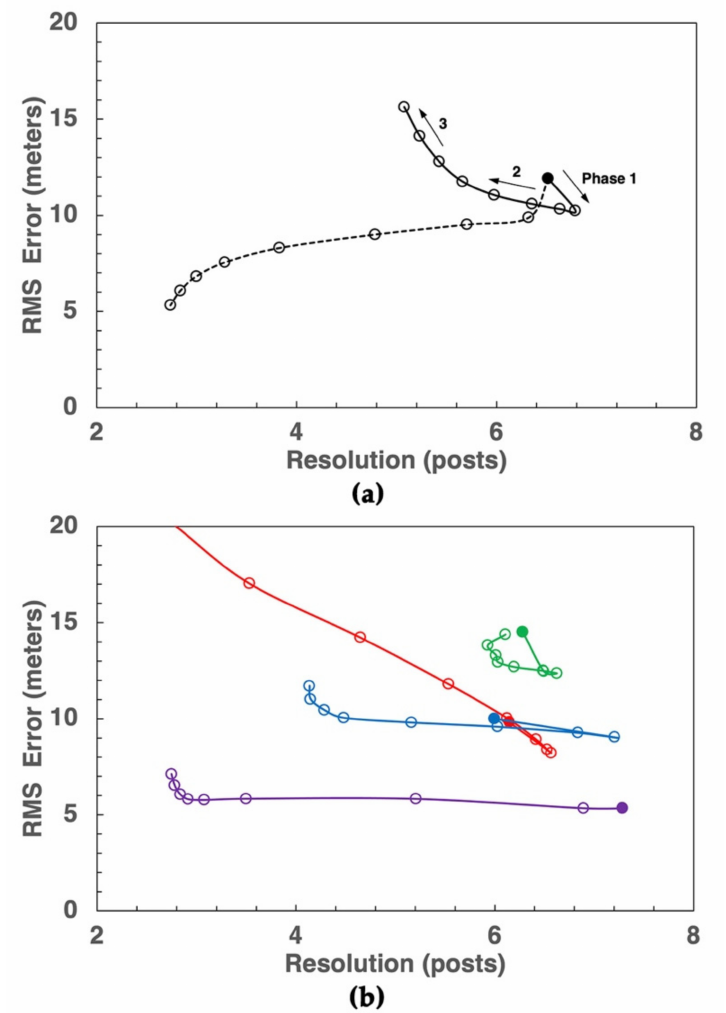
Figure 9. Quality factors for Gale HRSC DTMs refined by photoclinometry. Note that the normal- ization to image GSD (appropriate to stereo and used in Figure 6a) is not used here. Best-fit filter width (resolution) is normalized to the DTM and orthoimage GSD and vertical error is in meters as measured. Solid circles show values for starting stereo DTM; open circles show results after 1, 2, 4, . . . 128 iterations. ( a ) Results for full area covered by the HiRISE T1 DTM. Solid line is for actual image data with albedo variations corrected based on stereo DTM, dashed line is for a synthetic image with uniform albedo computed from the reference DTM. ( b ) Results for iteration with the real image for subareas of differing slope and albedo variation outlined in Figure 3a. Three phases of changing resolution and error as iteration proceeds (arrows) are labeled for the full area but are identifiable in the other curves. See text for